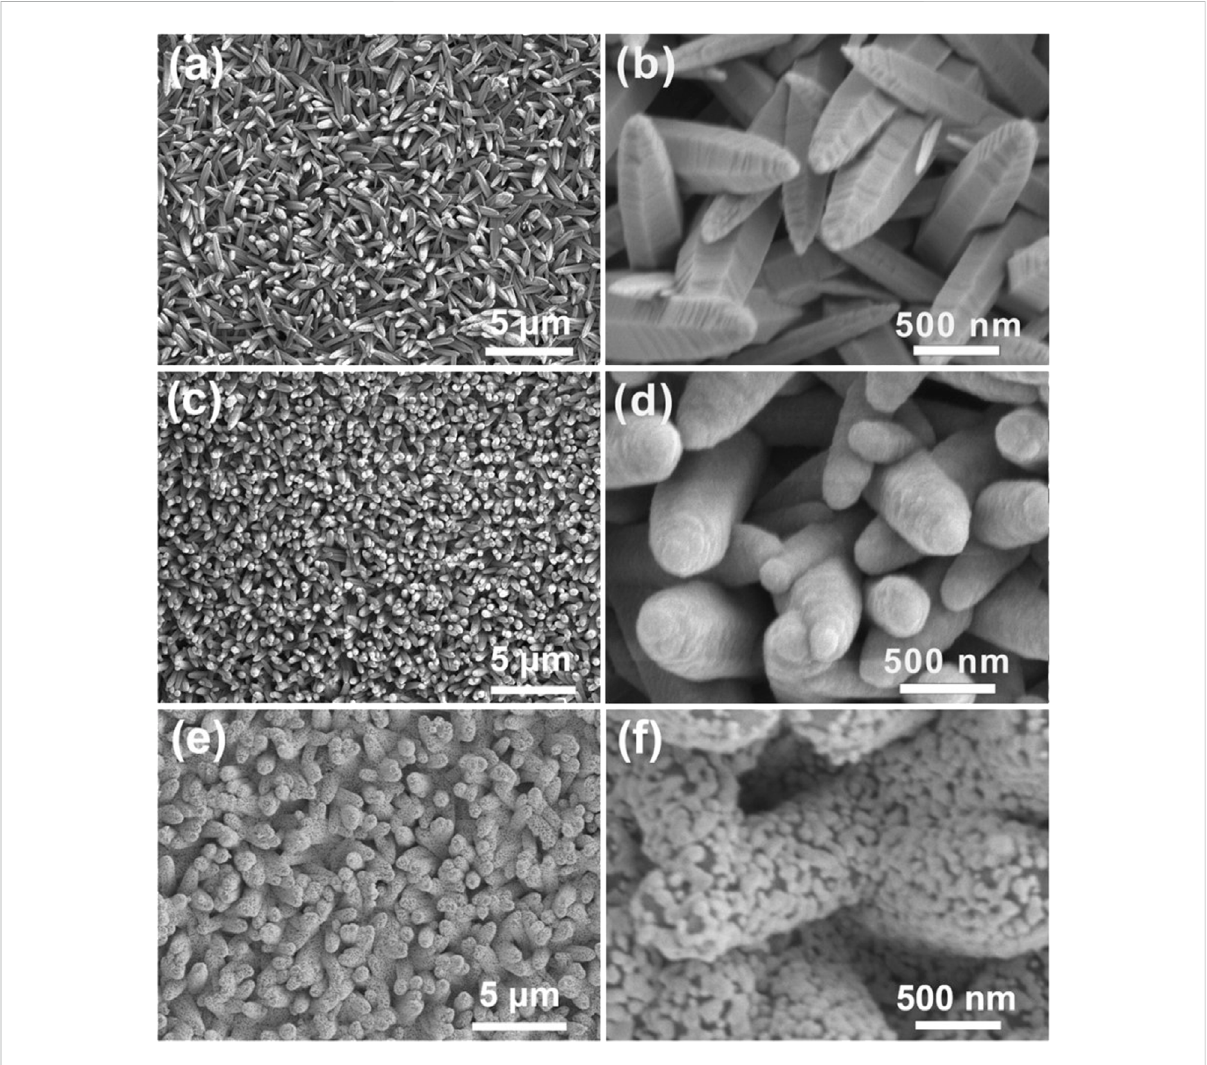
FIGURE 2 Morphologycharacterization. (A) SEMimageofZnOnanoconearrays. (B) Anenlargedviewof (A) . (C) SEMimageofTiO 2 nanotubearrays. (D)